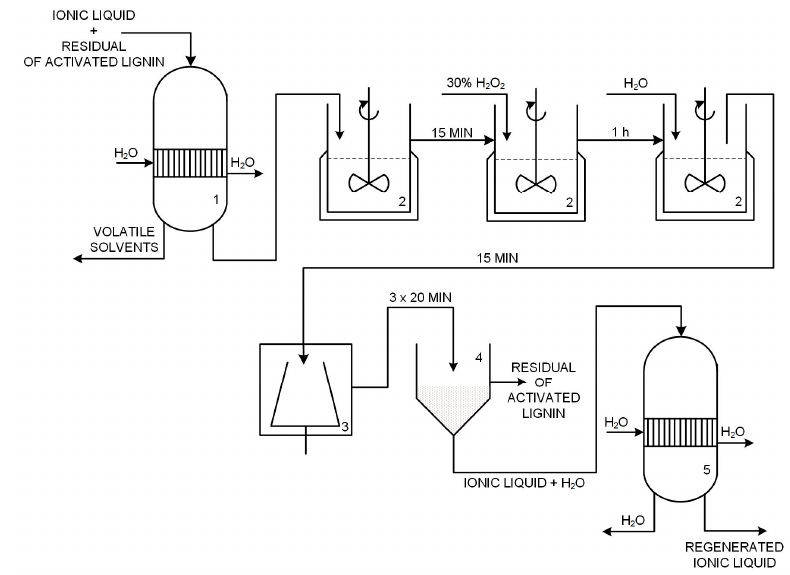
Figure 18. Technological scheme of regeneration of ionic liquids (1, 5—vacuum evaporator, 2—reactor, 3—centrifuge tube, 4—vacuum filter).